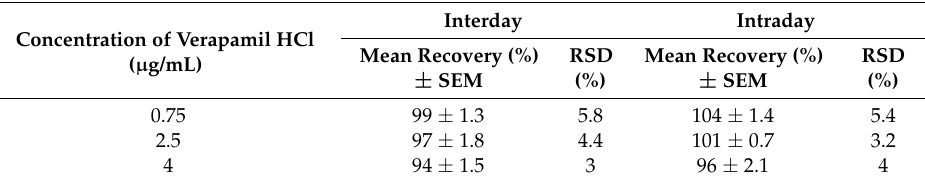
Table 1. Precision and accuracy of the method for measurement of verapamil HCl concentration. Each test was performed three